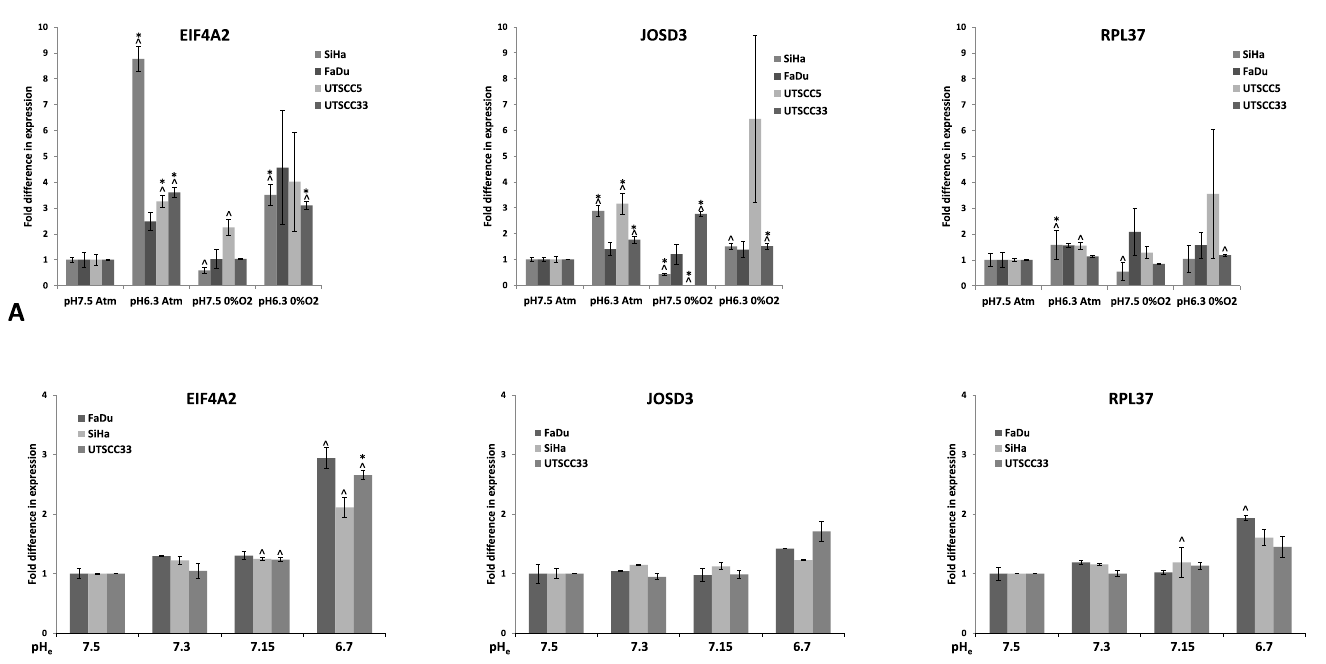
Fig 3. pH induction of identified genes. Relative levels of EIF4A2, JOSD3 and RPL37 mRNA measured by qPCR in SiHa, FaDu DD , UTSCC5 and UTSCC33 cells under different conditions. Levels are normalized to the control samples (pH 7.5, atmospheric oxygen level). Results are mean of three independent experiments (+/-SEM). (^) indicates p values < 0.05 compared to the control level. ( * ) indicates p values which are significant different from the control levels, when correction for multiple comparisons is applied.